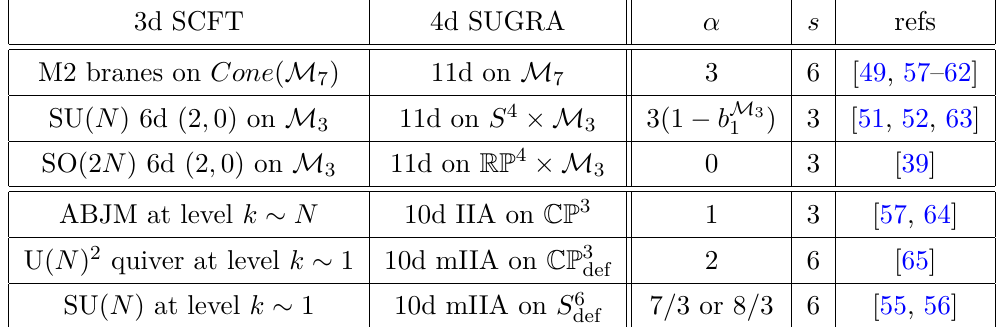
is a Sasaki-Einstein manifold 7